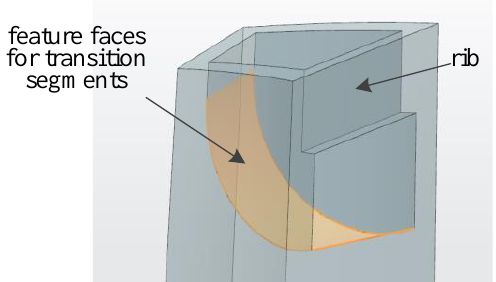
Figure 16. Recognition characteristics of elbow unit